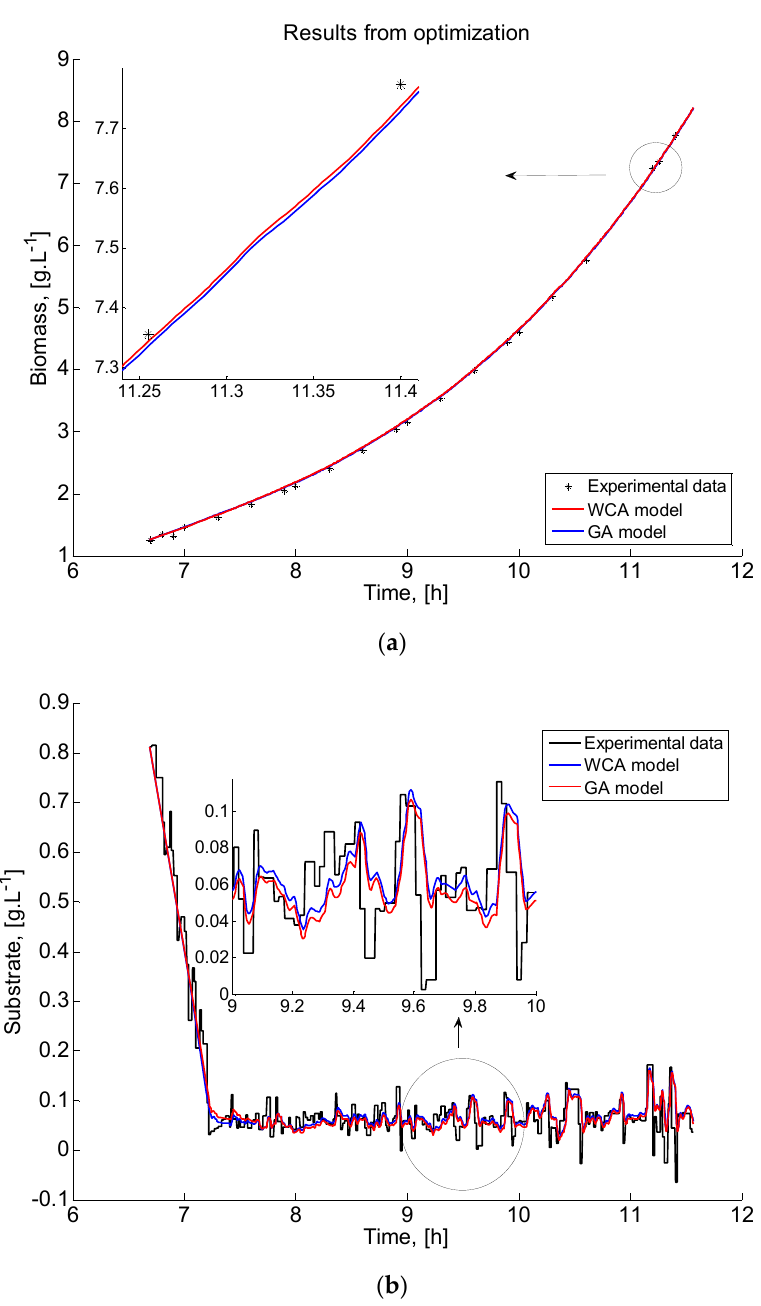
Figure 6. Case study 1 : comparison of the process variables time profiles obtained by GA and WCA: ( a ) biomass; ( b ) substrate.